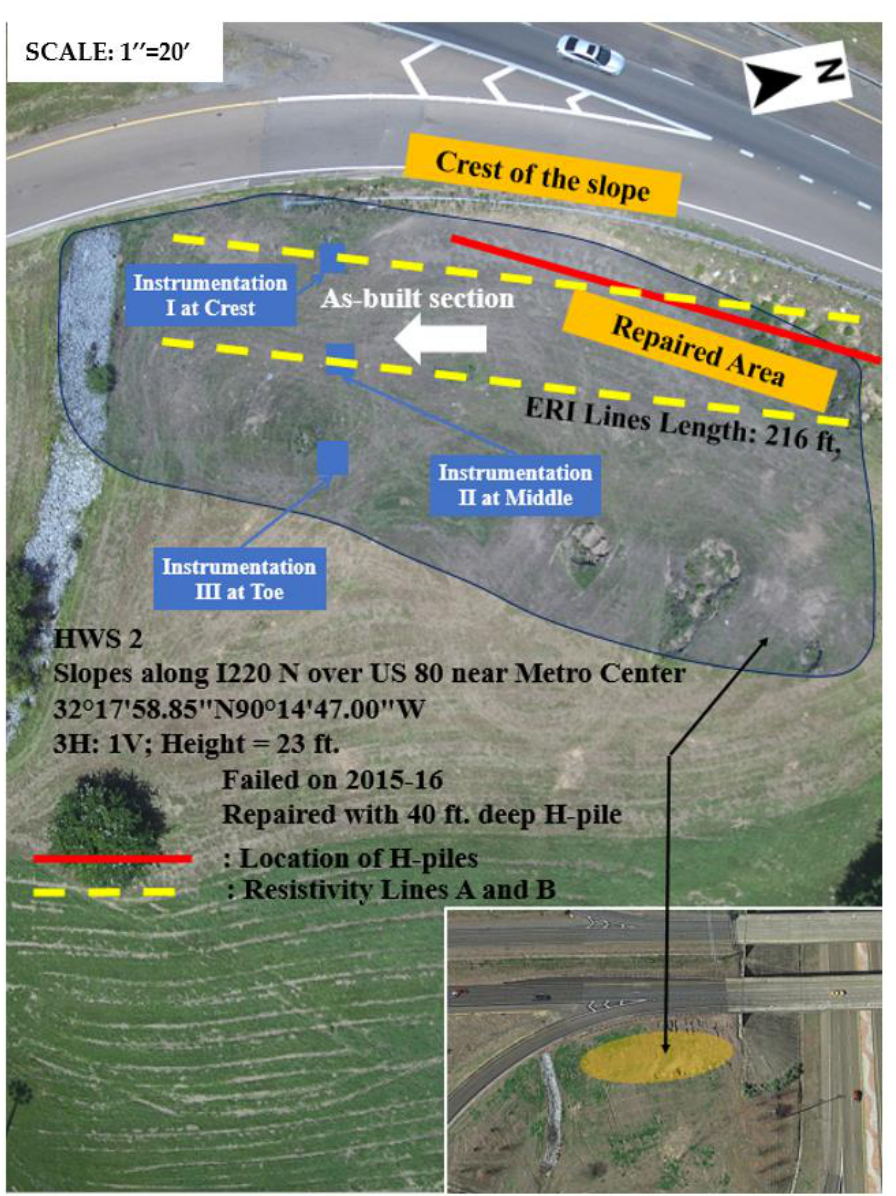
Figure 12. HWS 2 ERI and instrumentation layouts along with its characteristics (drone image-top view) ( 1′ = 1 ft = 0.305 m).